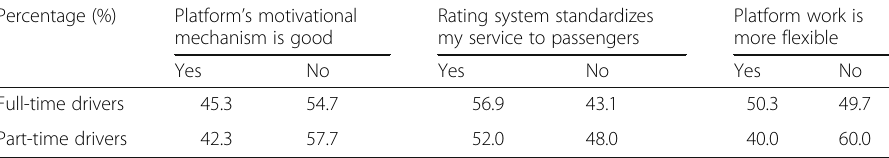
Table 3 Descriptive statistics of subjective approval Percentage (%)